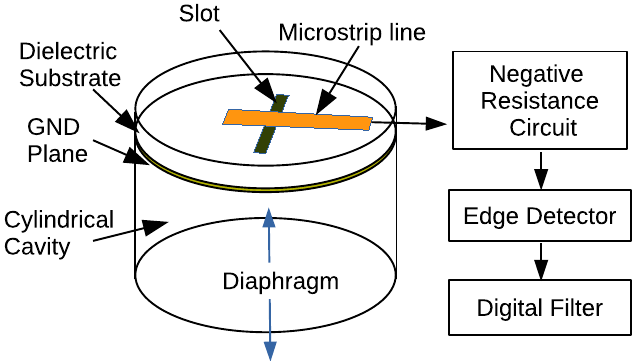
Figure 4. Microphone based on FDSM using a microwave cavity